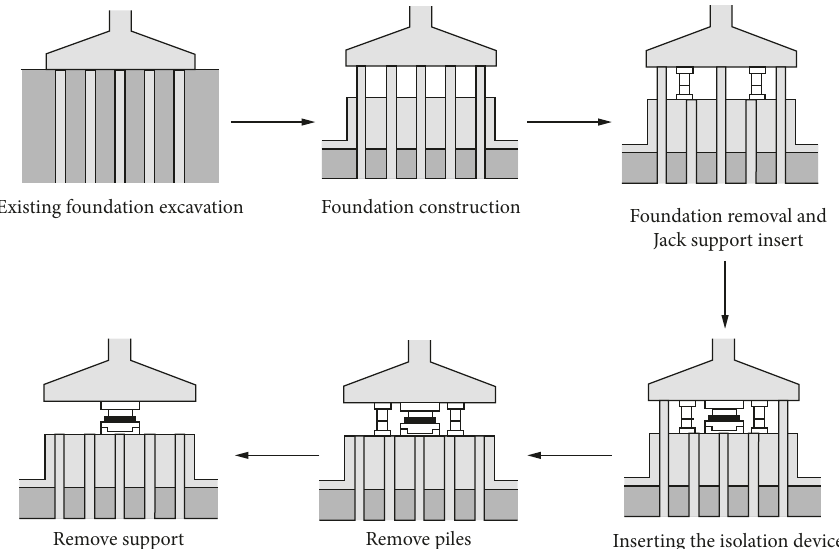
Figure 10: Isolation device construction.